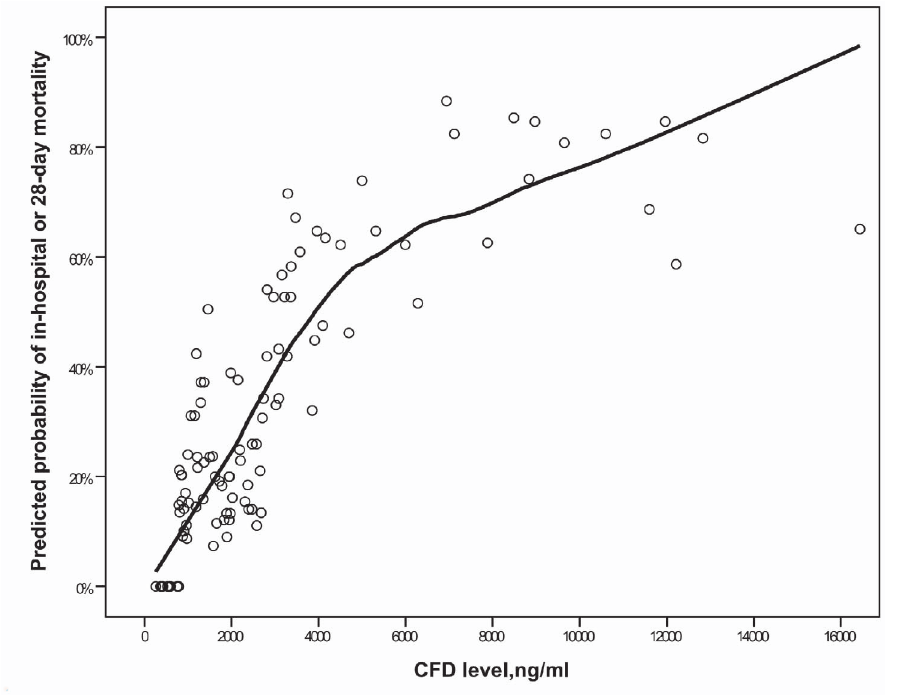
Figure 3. Locally weighted polynomial regression (LOESS) analysis for CFD based probability of in-hospital or 28-day mortality adjusted for APACHE II score on hospital